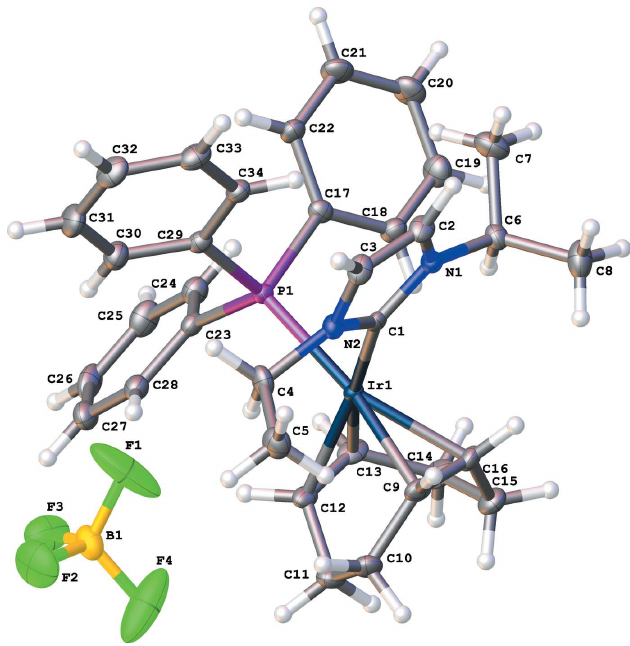
Figure 1 The asymmetric unit of the title compound, with displacement ellipsoids drawn at the 50% probability